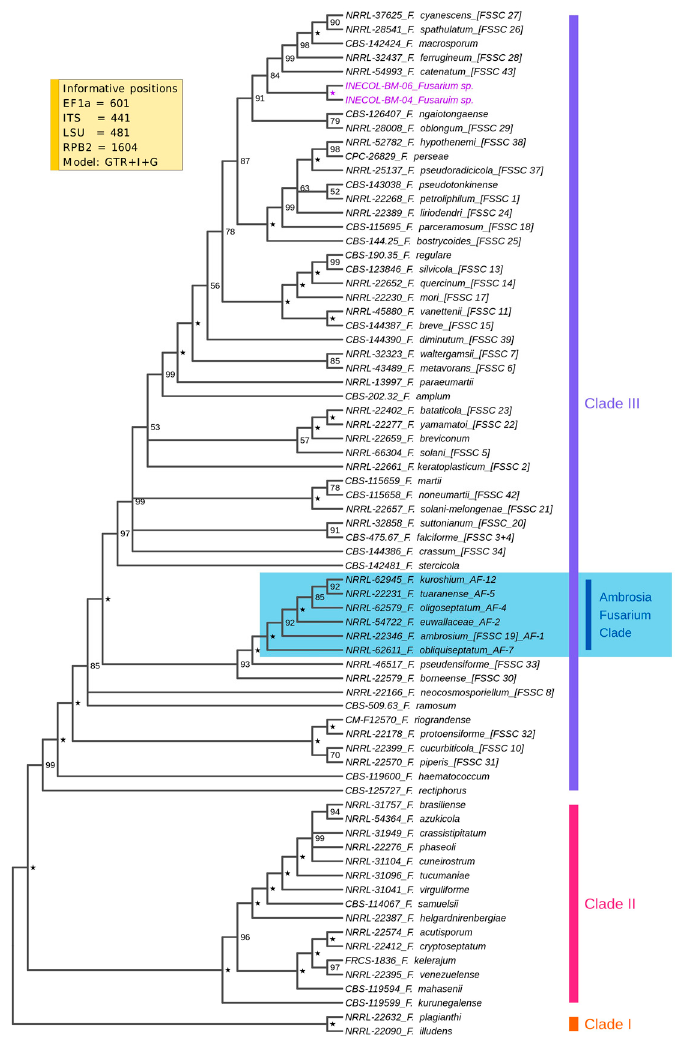
Figure 1. Cladogram of the phylogenetic relationship of Fusarium sp. INECOL_BM-04 and Fusarium sp. INECOL_BM-06 with members of the three clades of FSSC. Phylogeny constructed through Bayesian inference using a combined data set of four gene markers’ ( tef 1, ITS, LSU and the second- largest subunit of RNA polymerase II ( rpb 2)) sequences. The representative species of clades I, II and III are those proposed by [53]. Numerical designations referring to the informal nomenclature for phylogenetic species of FSSC (e.g., FSSC 1) are provided. The AFC is indicated. Support values from the Bayesian inference are indicated at the nodes. A star in the node indicates 100% support. INECOL isolates are